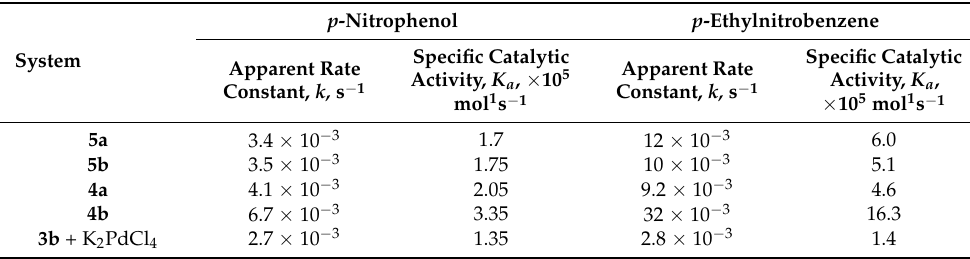
Table 1. Catalytic activities of different Pd-containing catalytic systems for the reduction of p - nitrophenol and p -ethylnitrobenzene 1